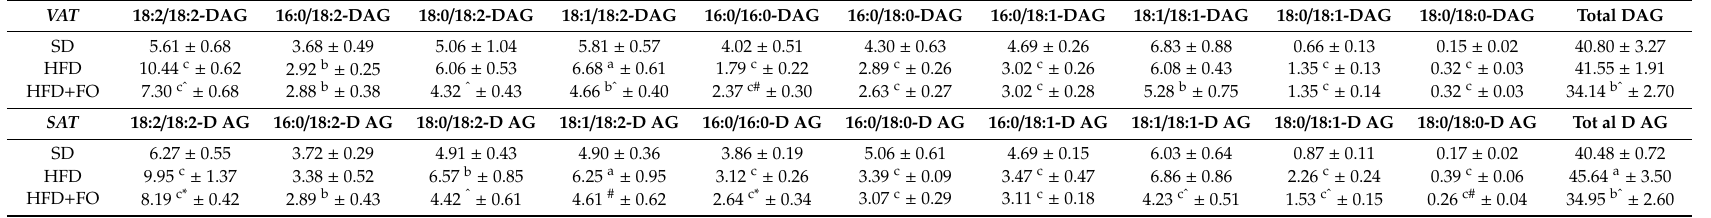
Table 4. Diacylglycerol content in visceral and subcutaneous adipose tissue in the studied groups (nmol / mg